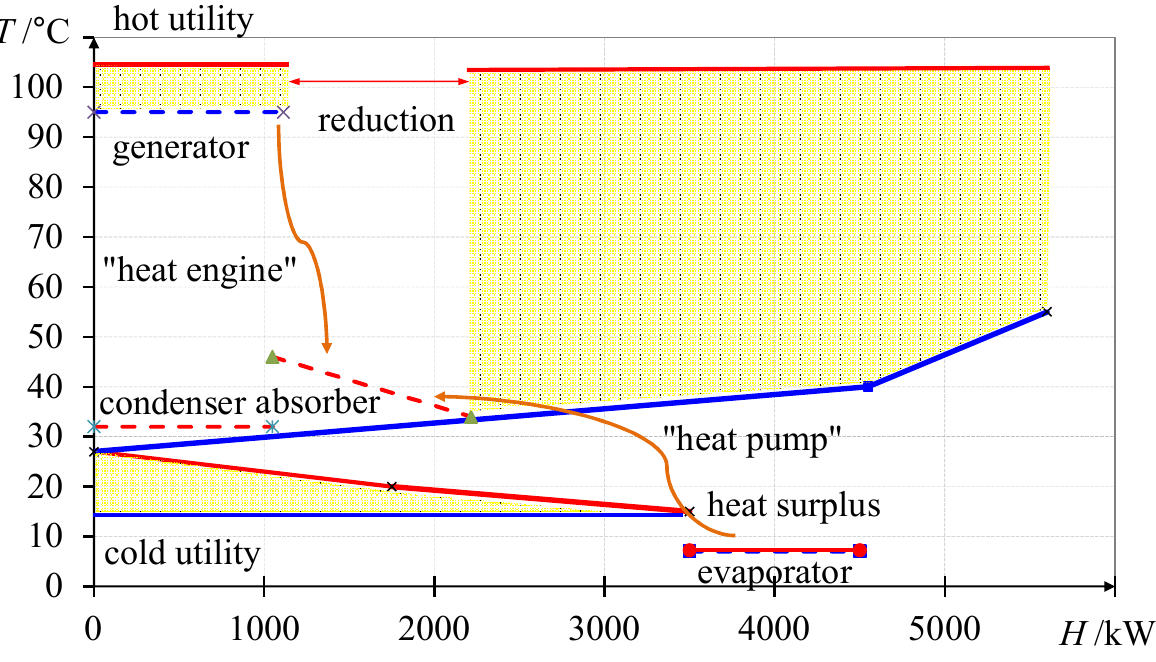
Figure 12. Integration of the AC with the process for case study 2.